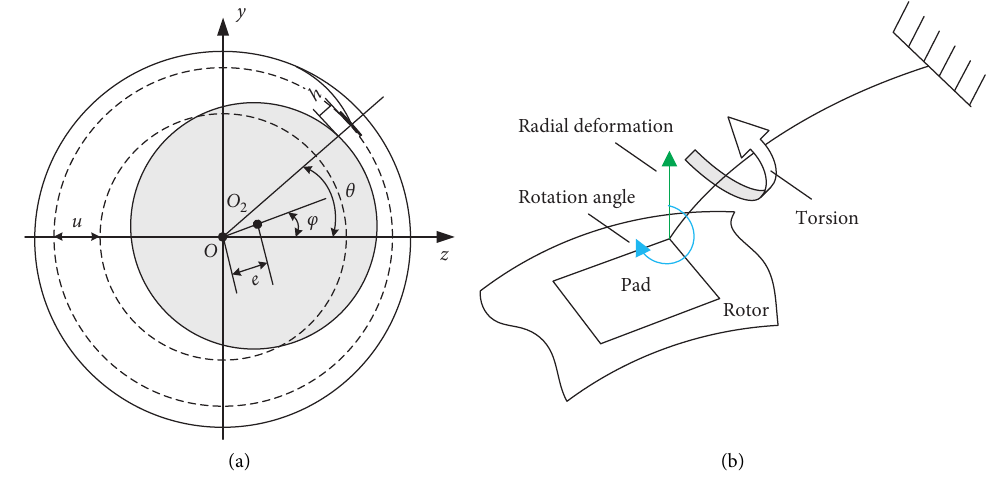
Figure 4: Schematic of the film thickness. (a) Axial schematic diagram. (b) Displacement of a finger.